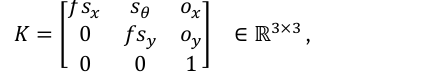
pixel coordinates with a prime superscript , whereas metric coordinates are indicated simply by ( ) . The rigid- body